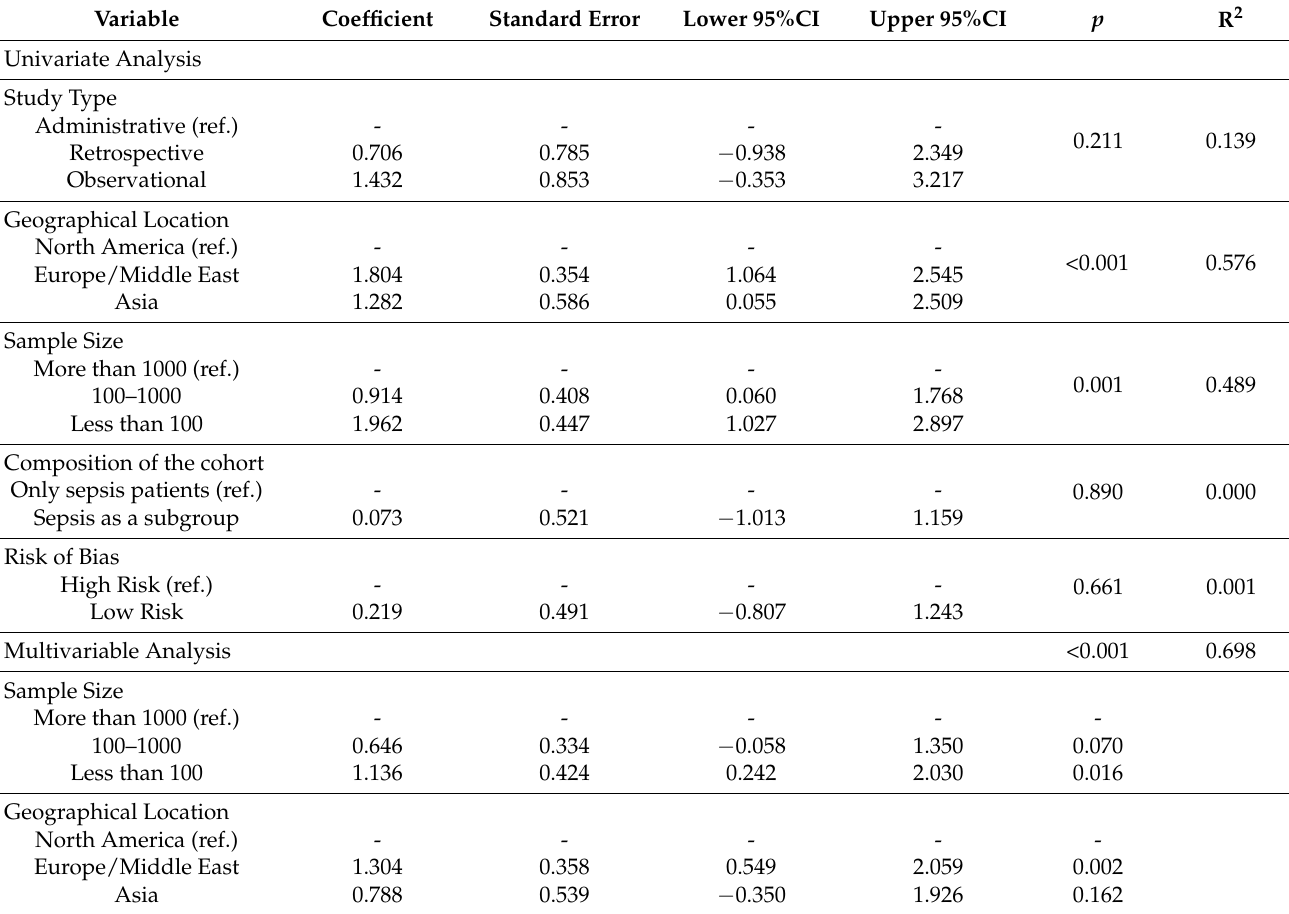
Table 3. Univariate and multivariable meta-regression analysis of NOAF